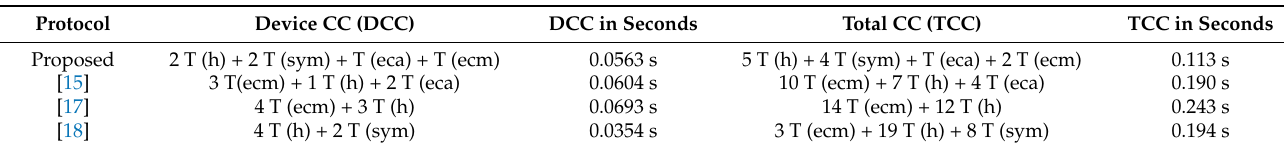
Table 4. Computational cost (CC) comparison in seconds.